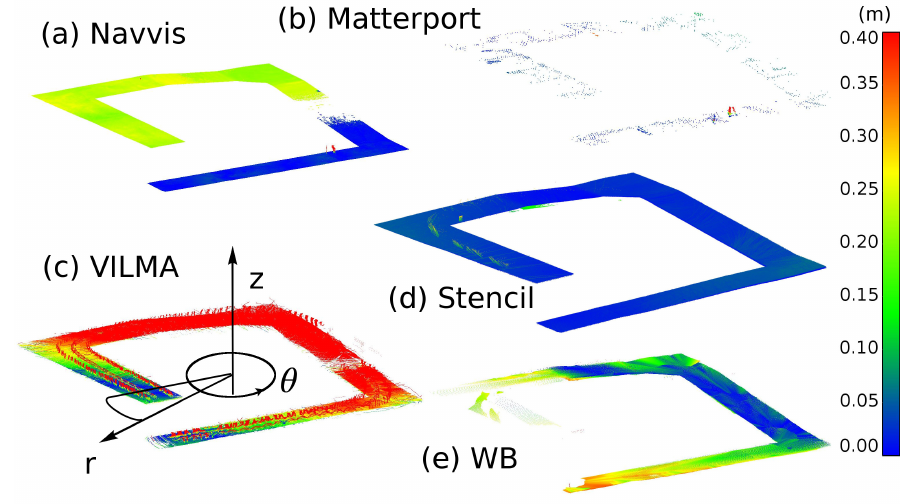
Figure 22. ( a – e ) Height error colored point clouds from the car park test site. The height error ∆ z is calculated between nearest neighbors. The color scale is from 0 (deep blue) to 0.4 (deep red). The cylindrical coordinate system is spanned as shown in ( c ), with θ = 0 starting from the lower floor and increasing towards the higher floor. The scheme for spatial discretization as a function of θ for Figure 23 is also shown. See the text for details on missing data in ( e ).